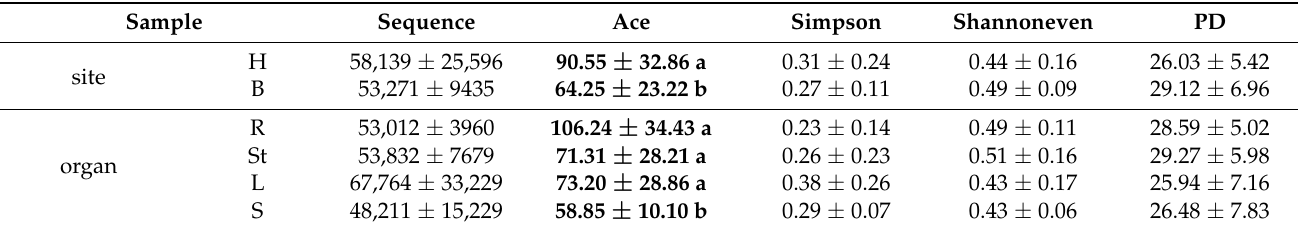
Table 1. Diversity indexes of endophytic fungi of S. alopecuroides (mean ±